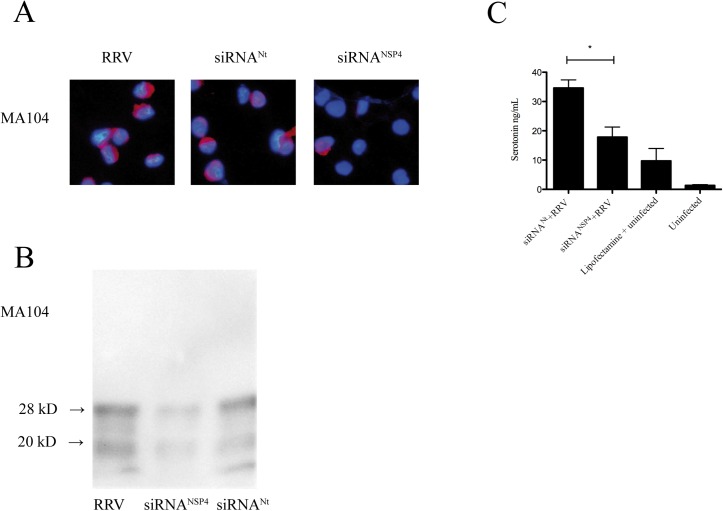
Extracellular stimulation of silenced NSP4 from MA104 cells attenuates secretion of serotonin from EC tumor cells.(A) MA104 cells were transfected with siRNANSP4. At 24 h p.i cells were infected with RRV at a MOI of 0.5 and after 7 h p.i cells were harvested and stained for NSP4 by a rabbit anti- NSP4 and a rhodamine-conjugated goat anti-rabbit (red) conjugate. Nuclear staining was performed with DAPI (blue). (B) NSP4 western blotting of transfected and infected MA104 cells. Protein quantification performed and the relative protein concentration was determined. 28 kD = glycosylated form of NSP4, 20 kD = non-glycosylated form of NSP4. (C) EC tumor cells stimulated for 1 h with cell supernatants from MA104 infected for 7 h. Serotonin secretion was analysed by ELISA. Data is presented as means + SEM.* = p ˂ 0.05 with Mann-Whitney U test; n = 4. siRNANt denotes non-targeting sequence.